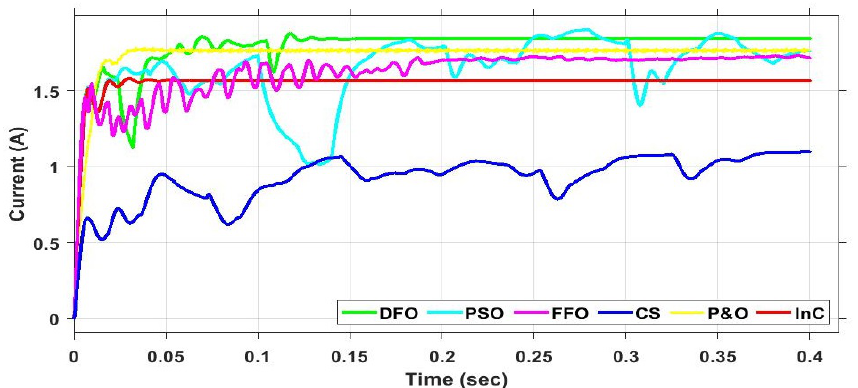
Figure 26. PS1 current comparison between all algorithms for MLPE Distributed PV system.